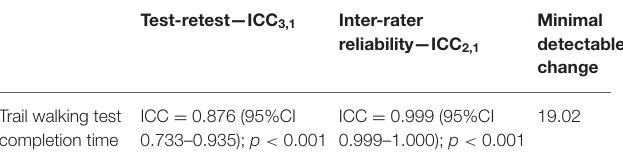
TABLE 4 | Inter-rater reliability, test-retest reliability of TWT completion time and minimal detectable change of subjects with